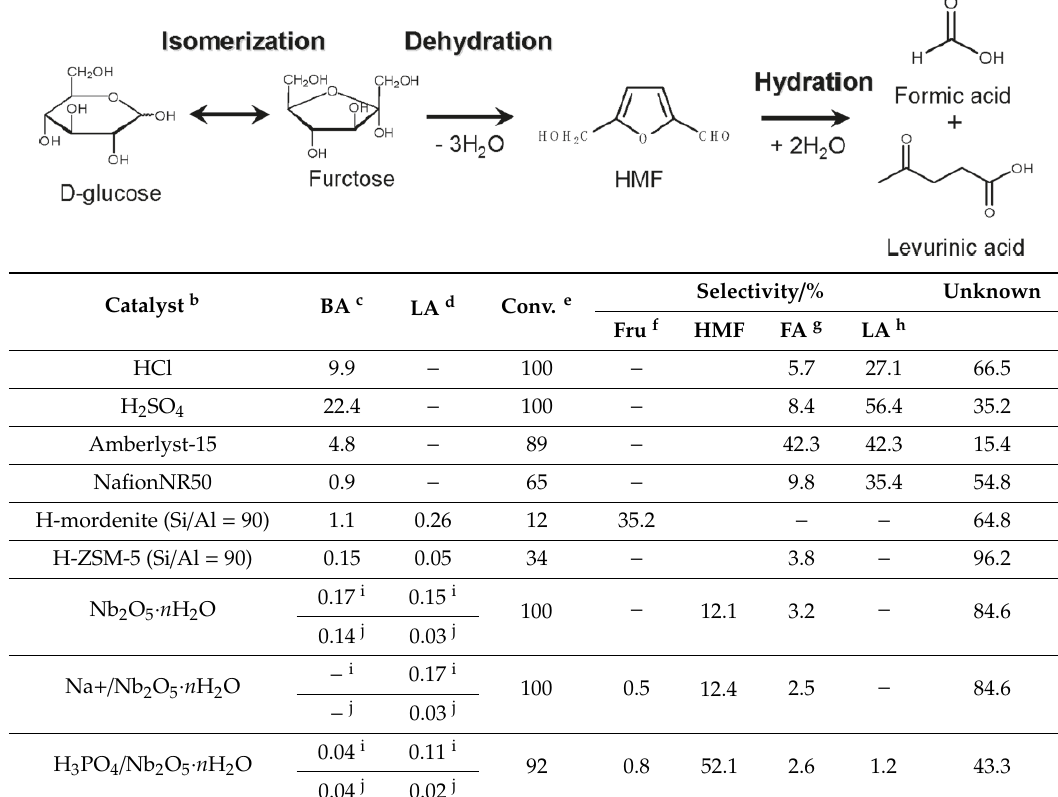
Table 1. Catalytic activity for the conversion of glucose into HMF in water a Reproduced with permission from [38]; copyright (2011), American Chemical Society.